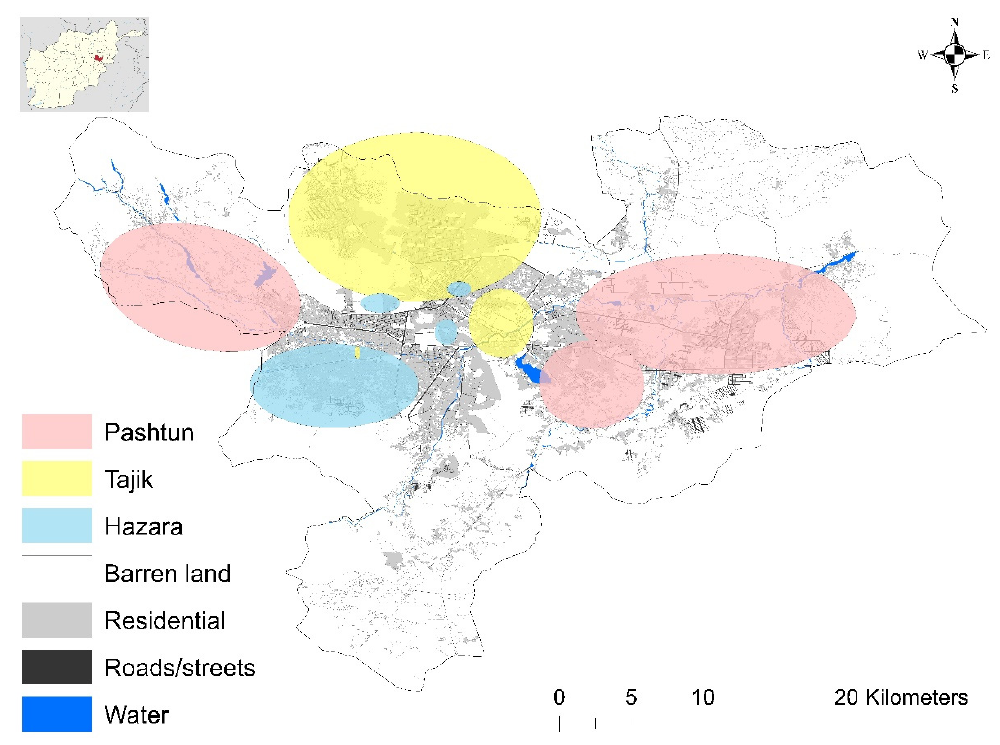
Figure 1. Kabul City Ethnic Map.